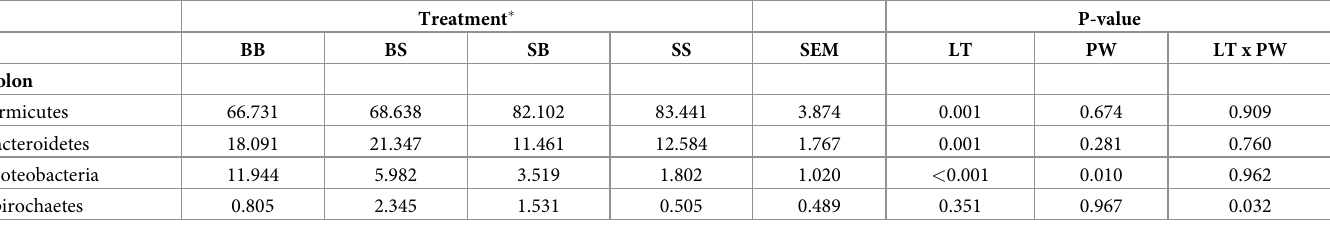
Table 6. Effect of supplementation of CH-YBG during gestation/lactation and/or post-weaning on differential relative abundance of bacterial taxa at the phylum level in pig colonic digesta on day 10 post-weaning. (least-square mean values with their standard error of means). Treatment